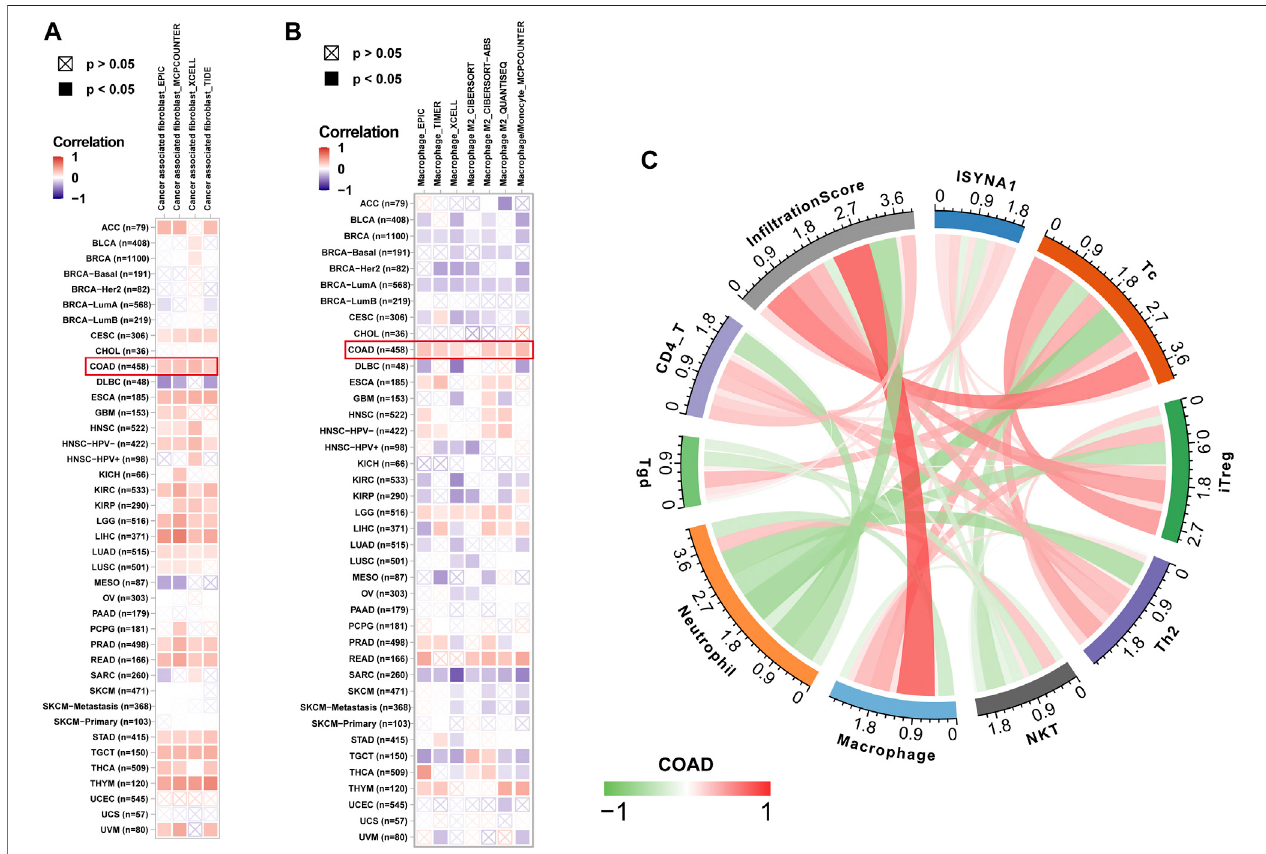
FIGURE9 | Immune in fi ltration analysis. (A) The relationship between ISYNA1 expression and in fi ltration levels ofCAFs in pan-cancer using the TIMER2 database. (B) The relationship between ISYNA1 expression and in fi ltration levels of TAMs in pan-cancer using the TIMER2 database. (C) The correlation between ISYNA1 expression and in fi ltration levels of 22 immune cells using data from the ImmuCellAI database. Signi fi cant results were shown (correlation p < 0.05).